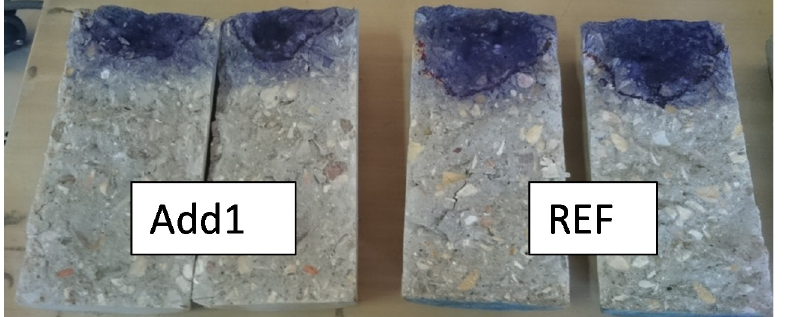
Figure 1. Aspect of two concrete samples after the permeability test and the Brazilian splitting test.